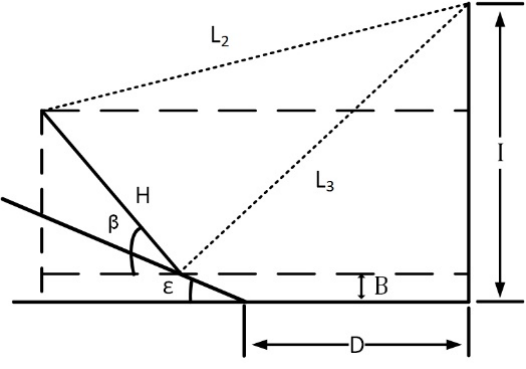
Figure 8. Collector, 𝐻 , on an inclined plane, 𝜀 , obscured by a building ( 𝐼 ) in front.